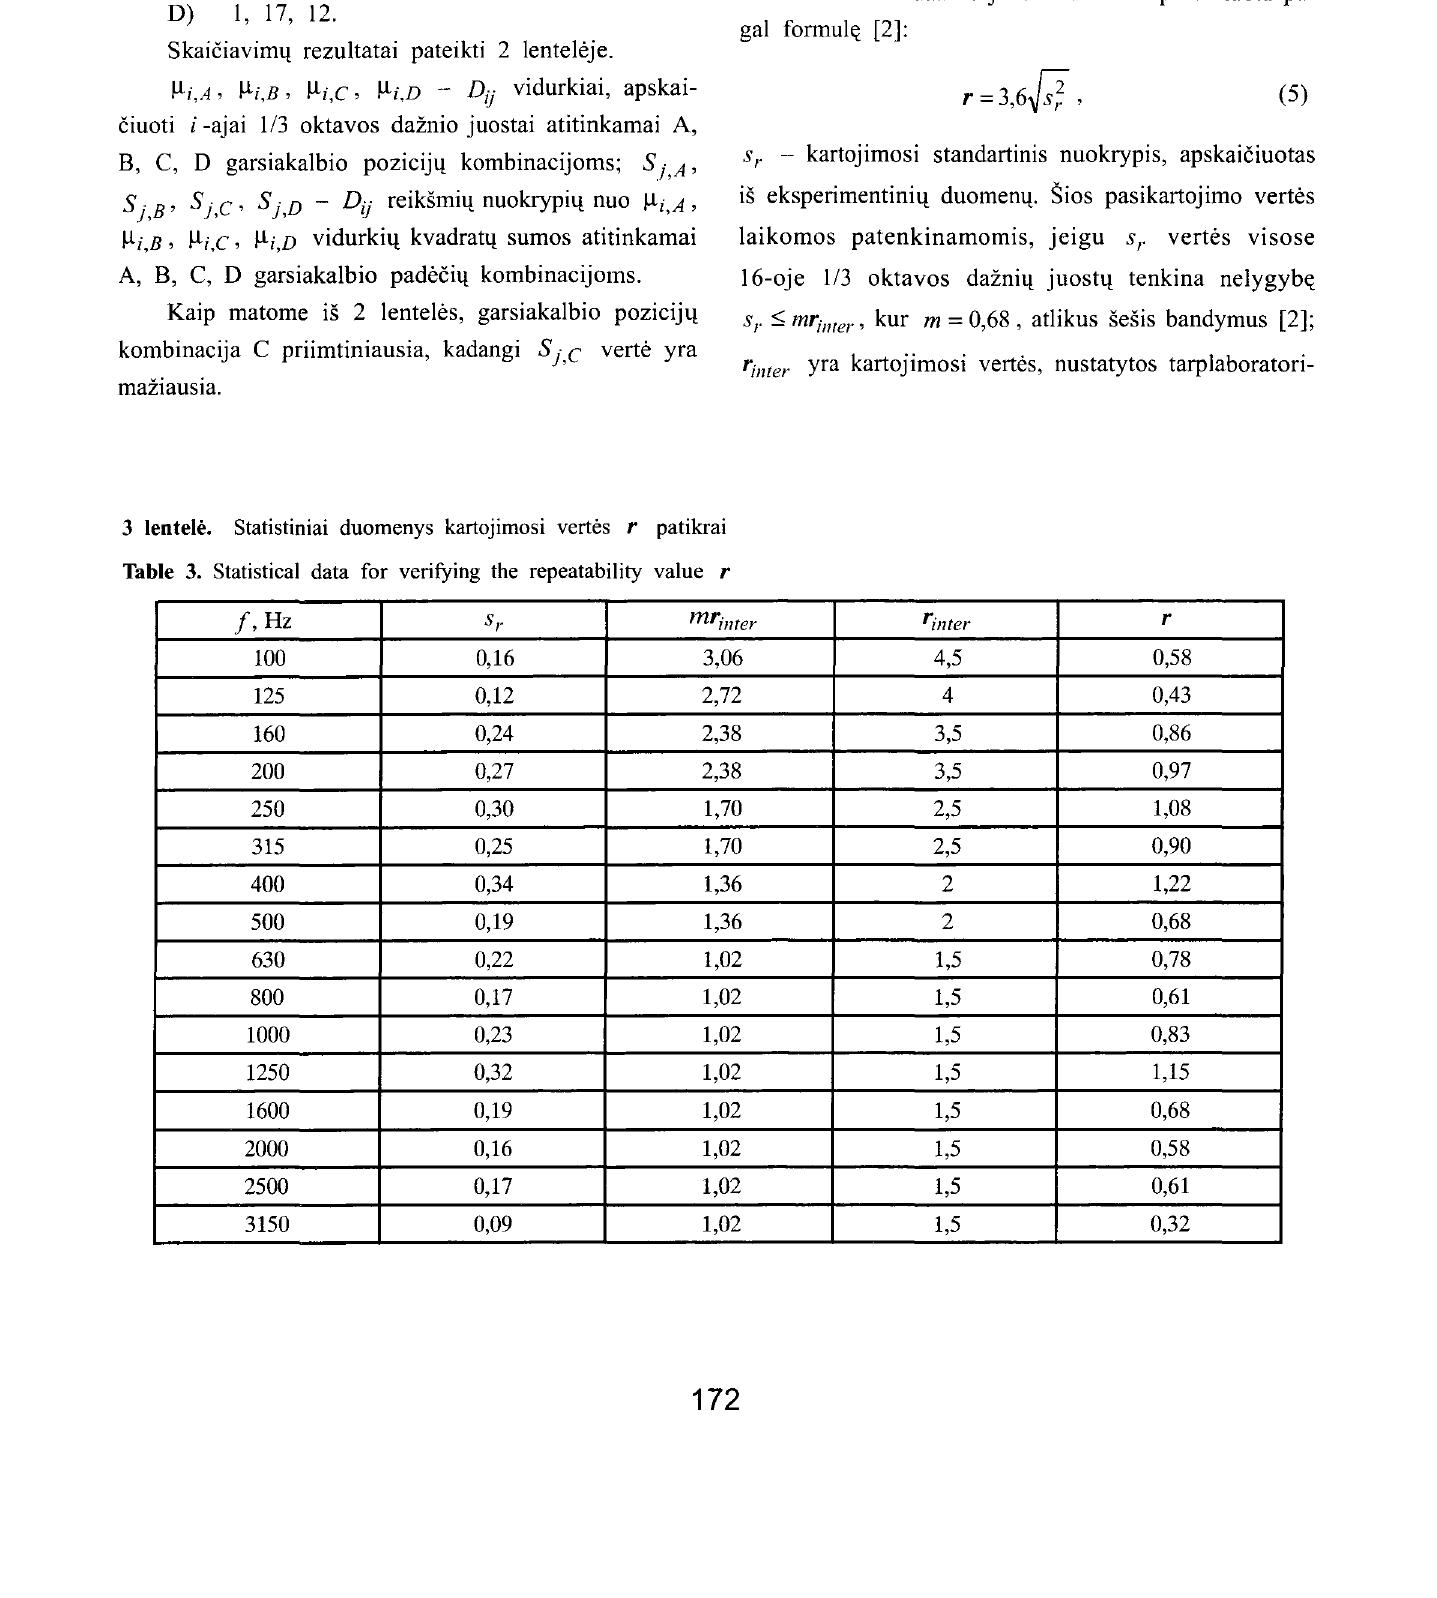
Table 3o Statistical data for verifying the repeatability value r f,Hz